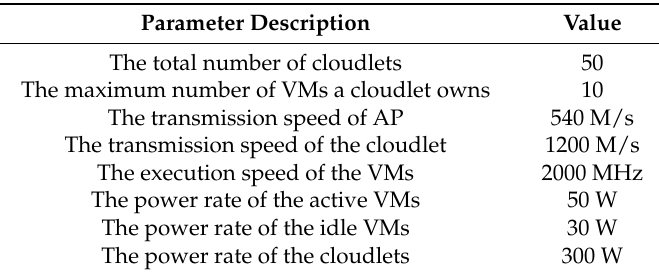
Table 2. Parameter